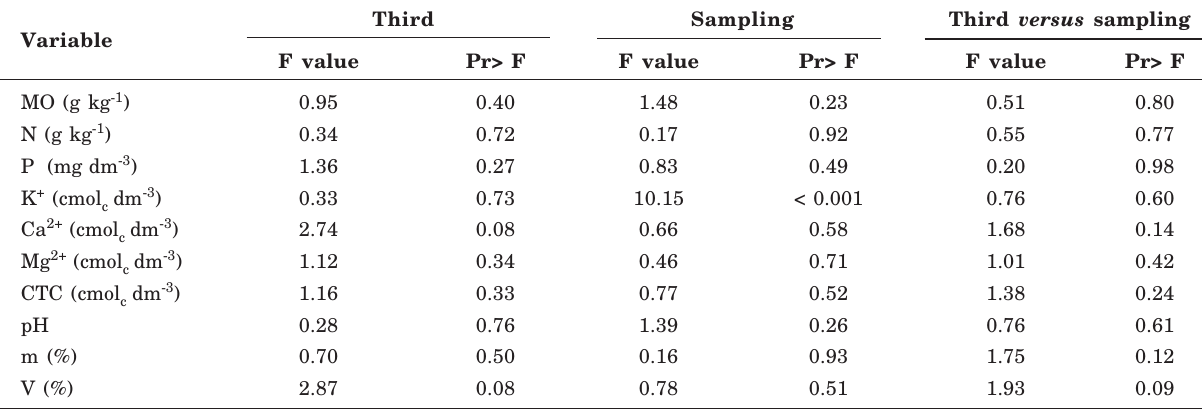
Table 2. Effects of soil sampling location (thirds) and sampling time on the studied soil chemical properties throughout the strawberry cycle, evaluated by means of repeated measures